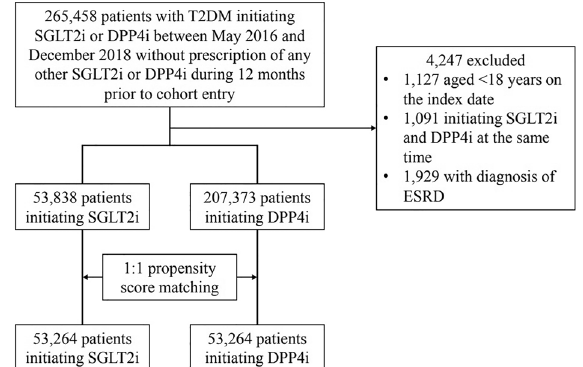
Figure 1. Flow diagram showing patient